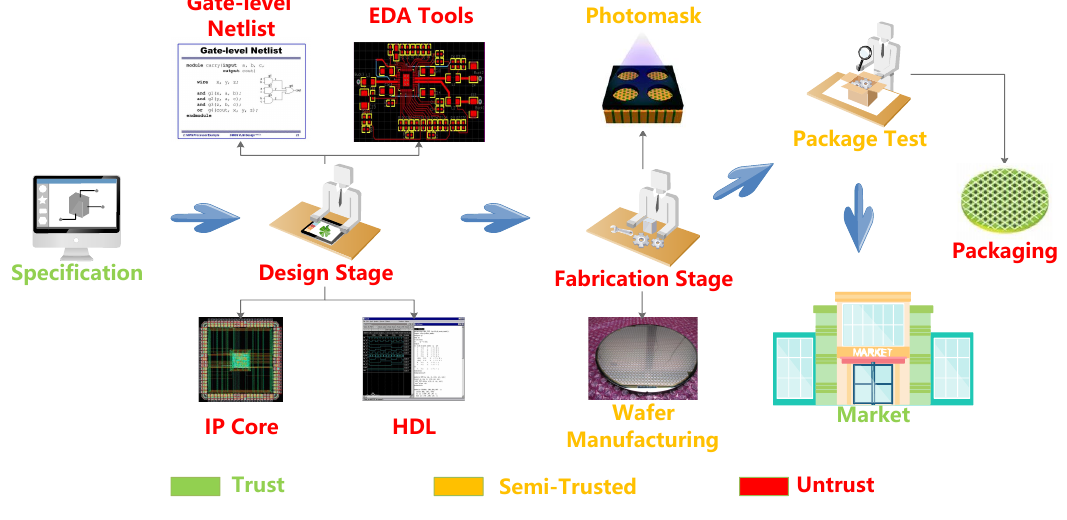
Figure 1. The credibility level of a modern IC life